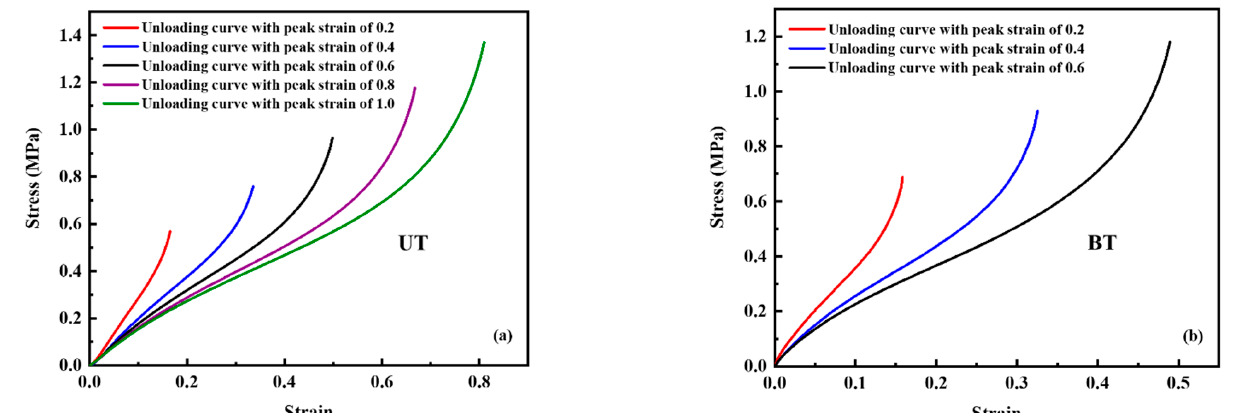
stretch ratio. The subscripts 1, 2, and 3 stand for the three principal directions. Table 2 gives the material parameters of the Ogden